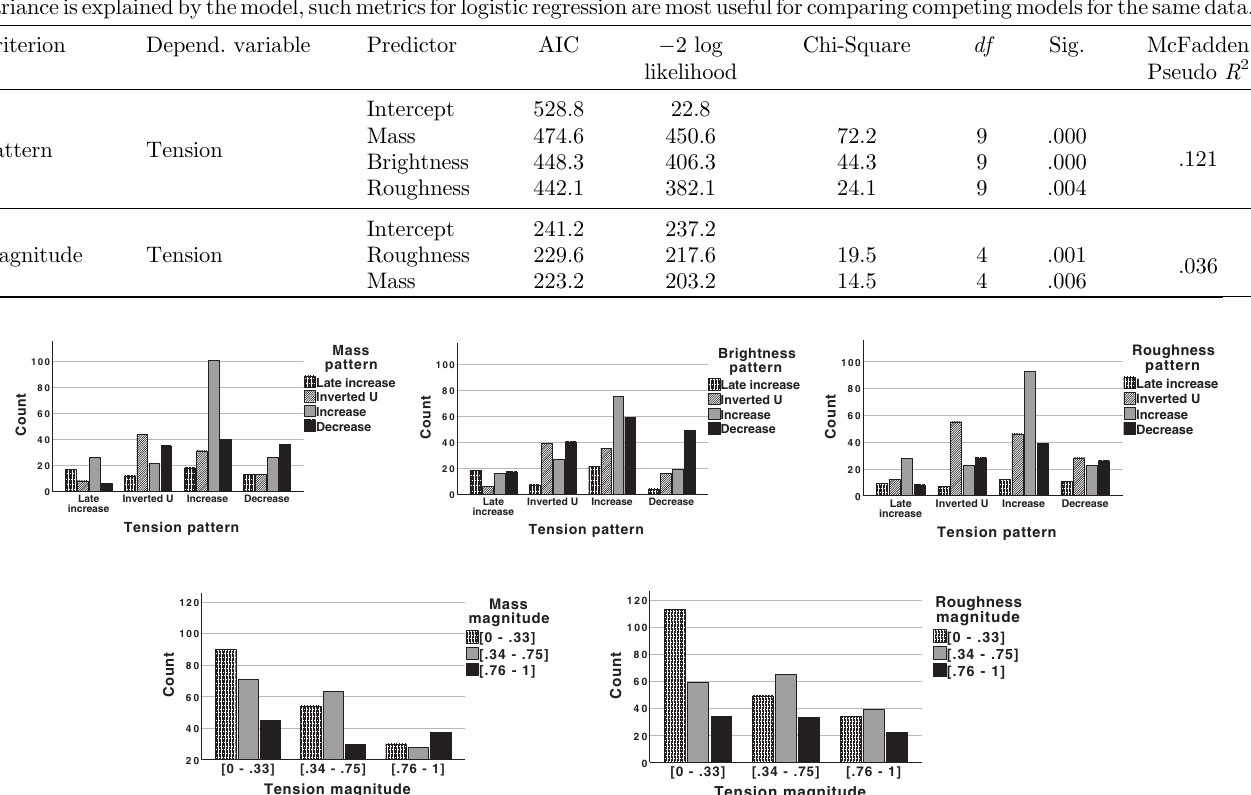
Table 3. Model fi tting criteria, effect selection tests and one goodness-of- fi t metric for regression models with tension as dependent variable and the three timbral semantics as predictors. Two different models were created based on the pro fi le pattern (multinomial logistic regression) and the maximum magnitude (ordinal regression). The Akaike information criterion (AIC) measures the model quality by balancing between goodness of fi t and parsimony. The lower the values the better the quality. (cid:3) 2 log likelihood is a measure of the unexplained variance by the model therefore lower values are also desirable. A Chi-square test assesses the signi fi cance of each additional predictor by measuring whether the difference in (cid:3) 2 log likelihood resulting from its inclusion is signi fi cant. Finally, McFadden Pseudo R 2 is a metric of the model ’ s goodness-of fi t. As there is not a straightforward interpretation of this metric, its values should not be judged by the standards for a good fi t in a regression analysis [24]. Although in general a larger value means that